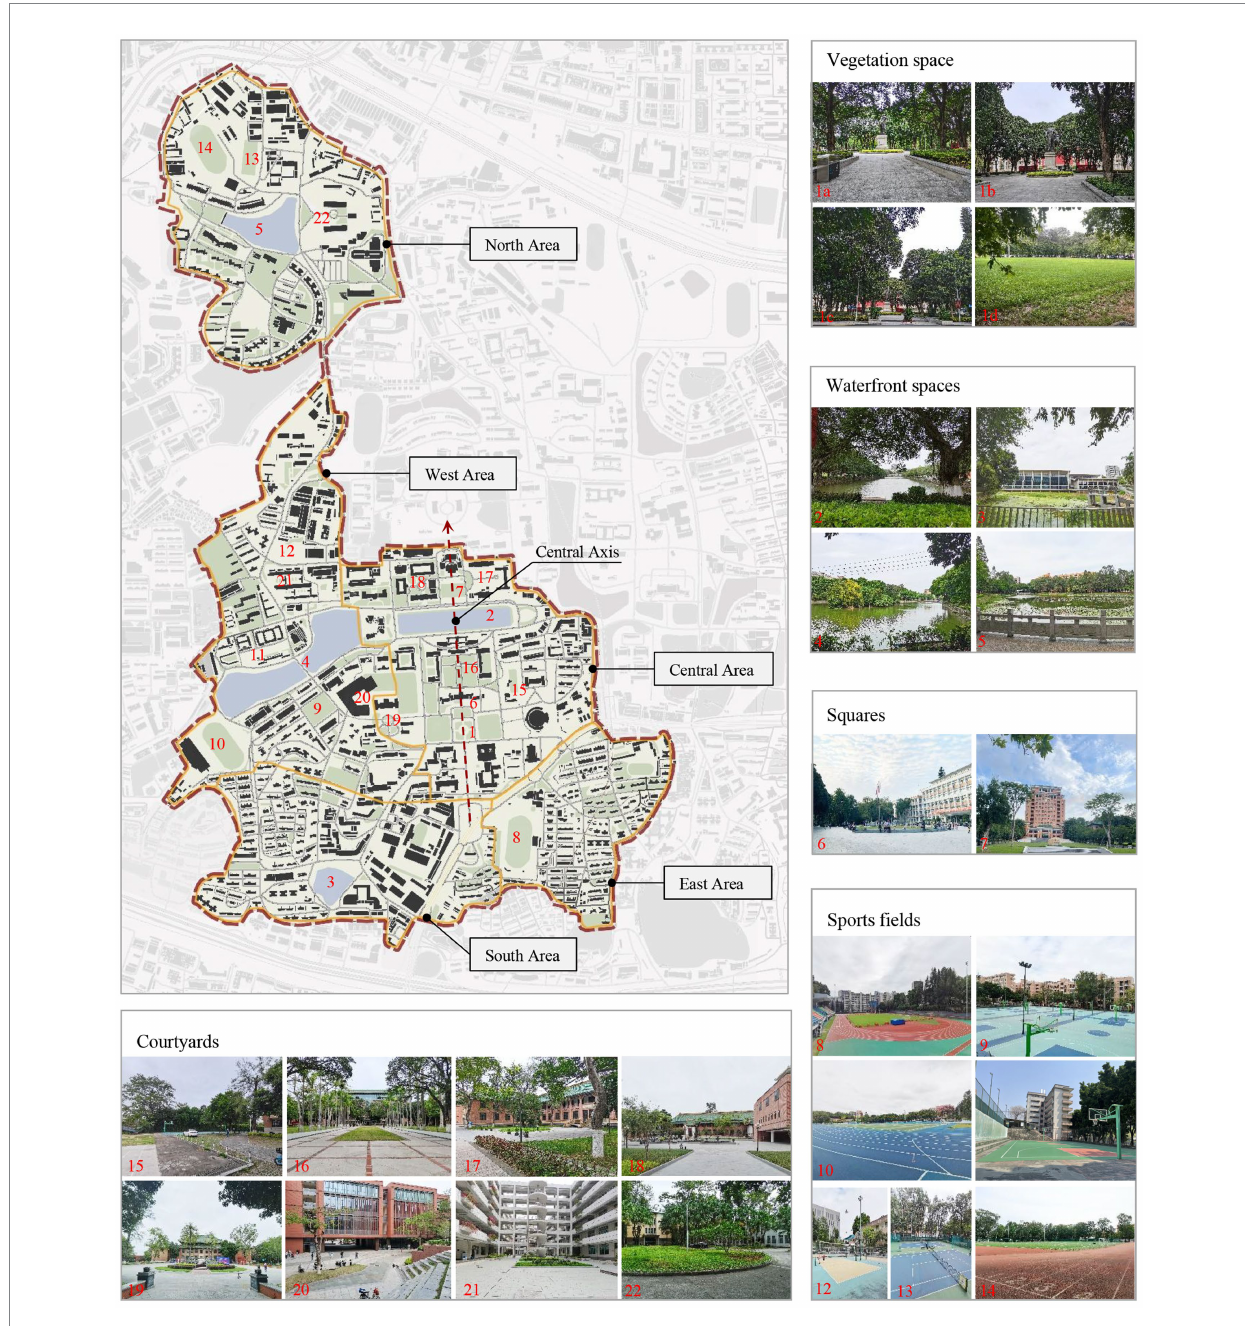
FIGURE 4 Master plan of SCUT Wushan campus and 22 researched common